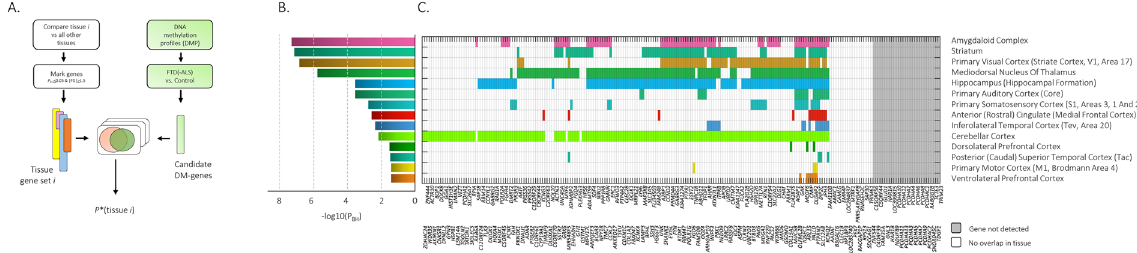
Figure 2. Tissue enrichment for FTD-ALS based on the brain tissue specific DNA-methylation profiles of BrainSpan. ( A ) The hypergeometric test is used to compute P -value for each tissue based on the following parameters; total number of genes (M), number of tissue specific genes (K), number of significant differential methylated genes (N), and the overlap of significant differential methylated genes and the genes in the tissue specific gene set (x). The final P -value ( P * ) is corrected for multiple testing using Benjamini and Hochberg, and used for tissue selection with P BH < 0.05. ( B ) Enriched tissues in FTD-ALS sorted in -log10( P BH ). ( C ) Genes are colored with the brain tissue specific color if overlap is seen with any of the significantly differential DNA- methylated genes in